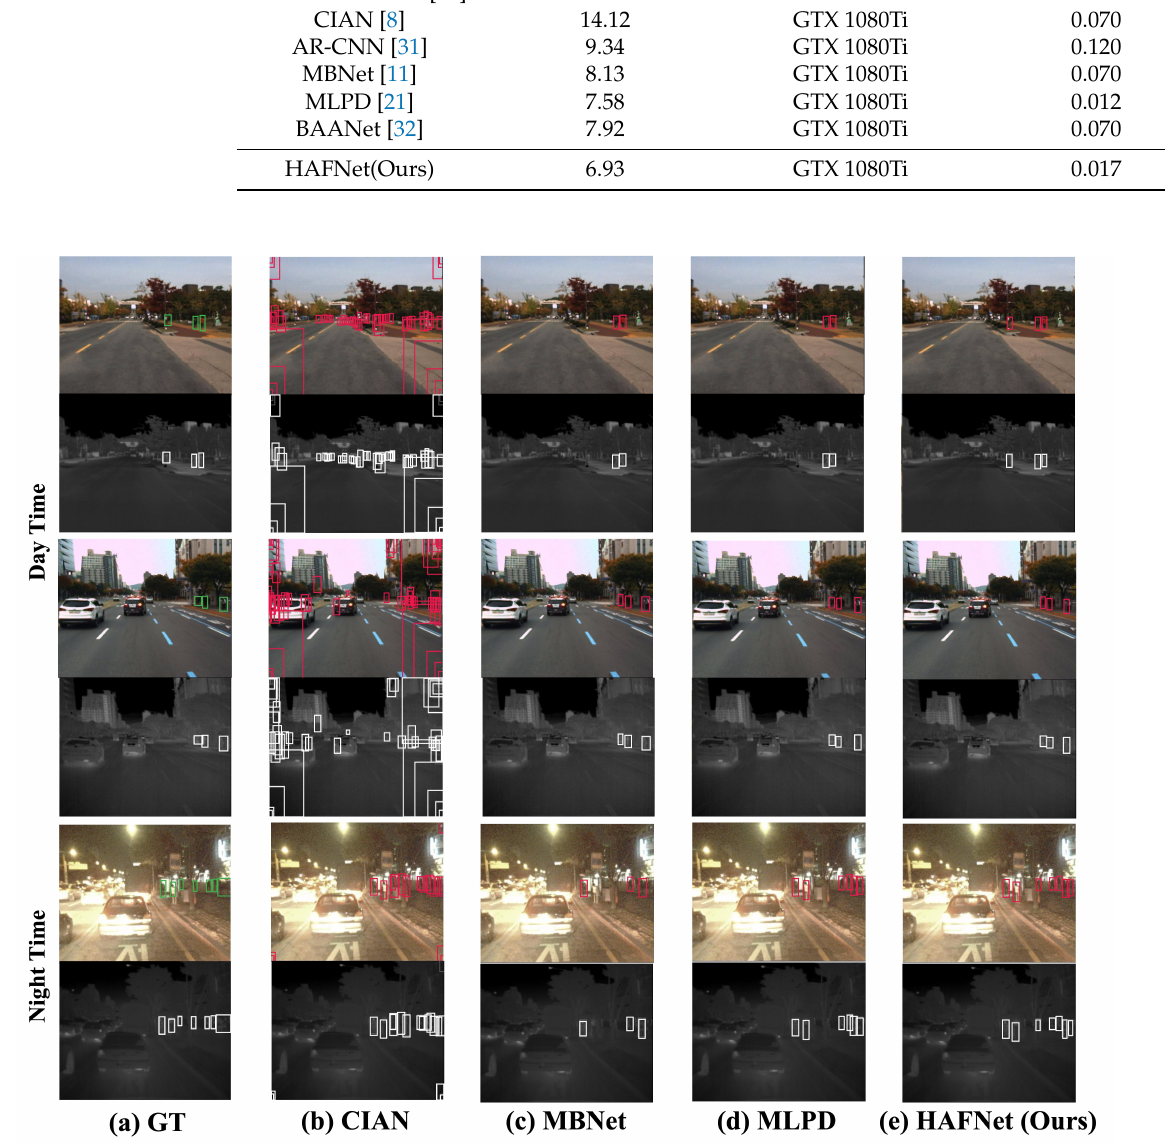
Figure 4. Qualitative evaluation of HAFNet with three top ranked methods, i.e., CIAN [8], MBNet [11] and MLPD [21]. The green rectangles denote the ground truth, while the red ones denote the detection results. ( a ) Ground truth. ( b ) Results of the CIAN [8]. ( c ) Results of the MBNet [11]. ( d ) Results of the MLPD [21]. ( e ) Results of our